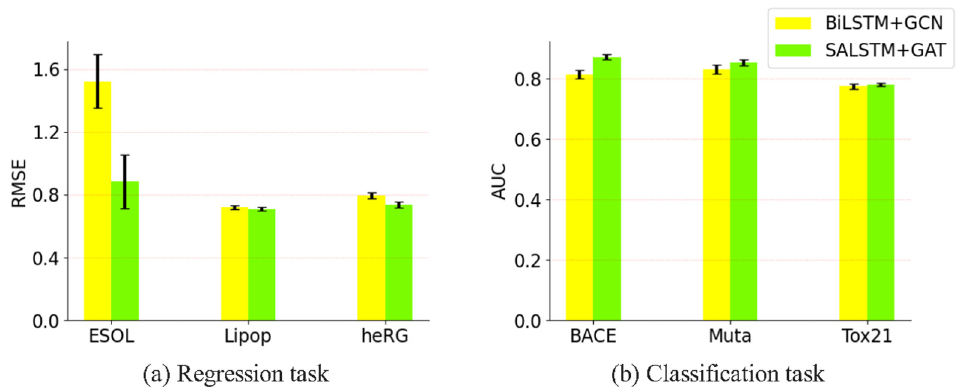
Figure 8. Comparing the effect of attention on the performance of the model. ( a ) The performance of the regression task. ( b ) The performance of the classification task. Error bars indicate standard deviation under 5 ‐ fold cross ‐ validation.